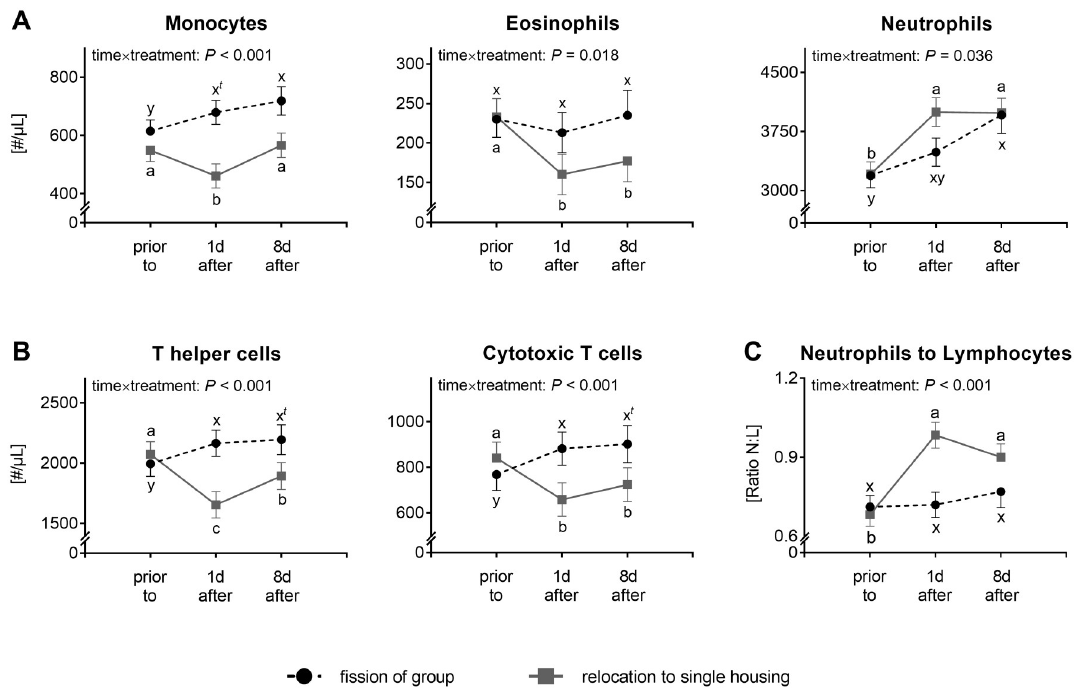
Fig 3. Numbers of various leukocytes types in blood of horses exposed to either changes in group composition or relocation to single housing. (A) Numbers of peripheral innate immune cells; (B) Numbers of peripheral T cell subsets; (C) Ratio of the numbers of neutrophils to lymphocytes (N:L ratio) in blood. Immune cell numbers are depicted as LSmeans ± SE (only shown in one direction in case of overlapping SE; N = 5–13) and results of linear mixed model analyses are shown within the graph sparing the results of effect of time and effect of treatment if time × treatment interaction with P < 0.05. Different lowercases depict significant differences ( P < 0.05) or tendencies ( P < 0.1; depicted by additional t ) between point in times within particular treatment (fission of group: x-y; relocation to single housing: